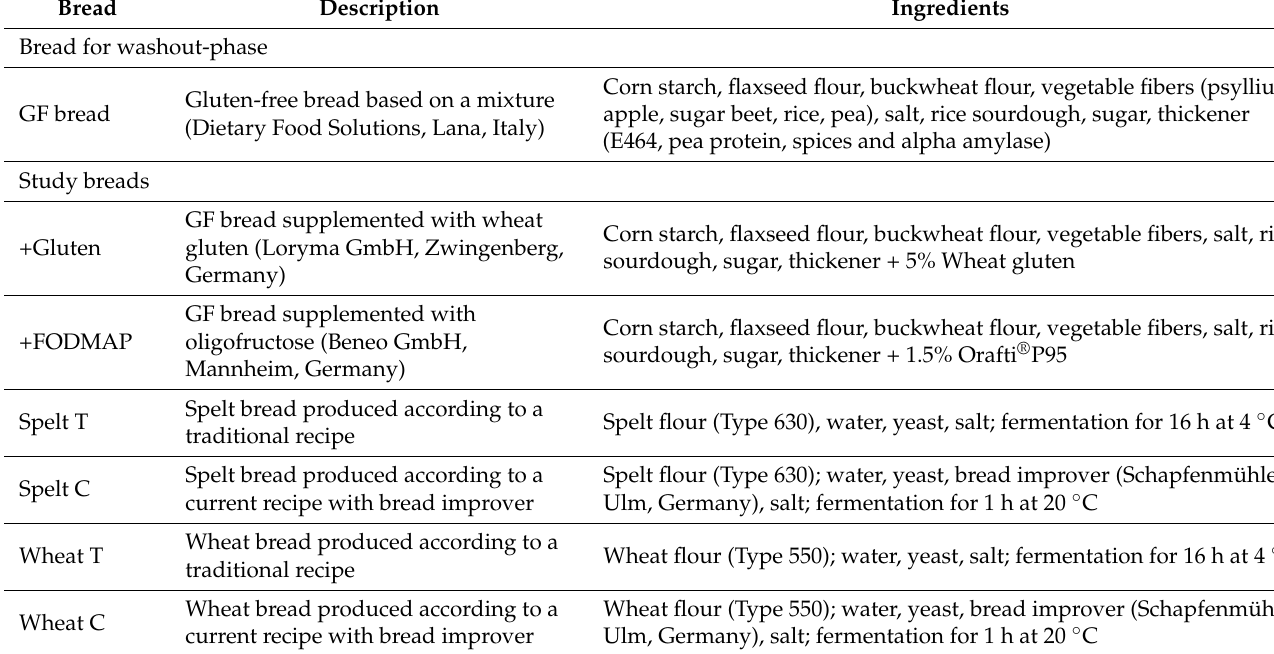
Table 1. Composition of the gluten-free bread and the different study breads. Description